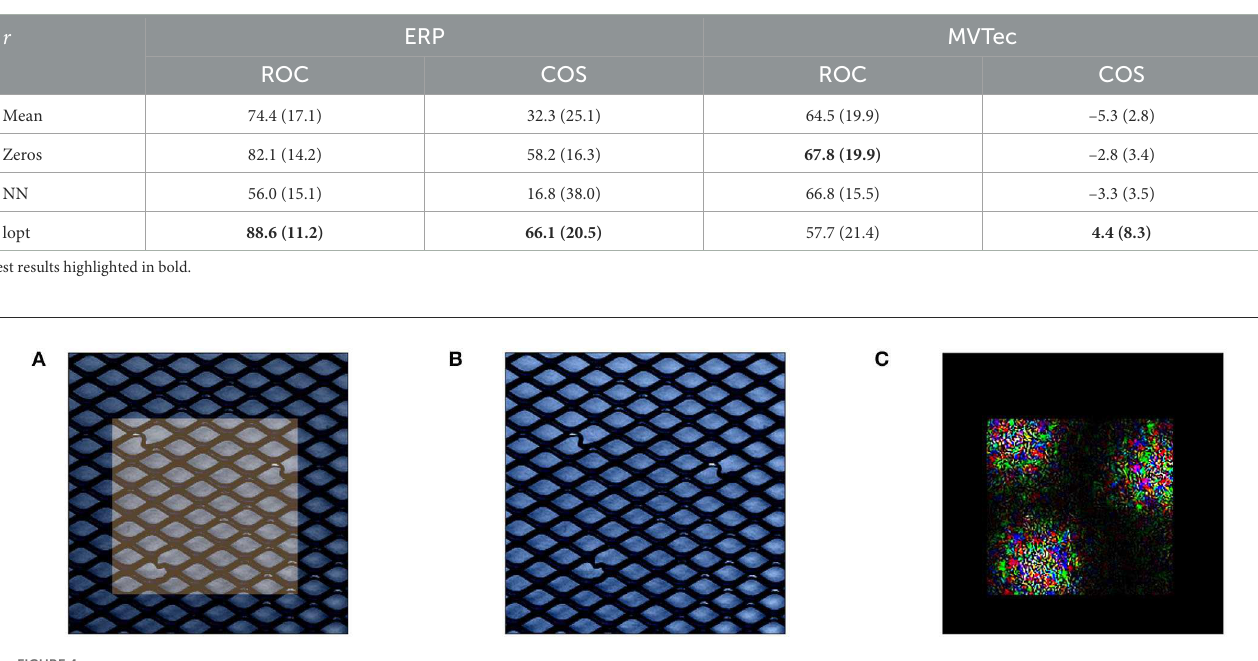
TABLE 2 Mean and standard deviation of SHAP performance for ERP and MVTec data when using mean of training data (mean), zero vector (zeros), nearest neighbor in training data (NN), and optimized data points (lopt) as reference r .